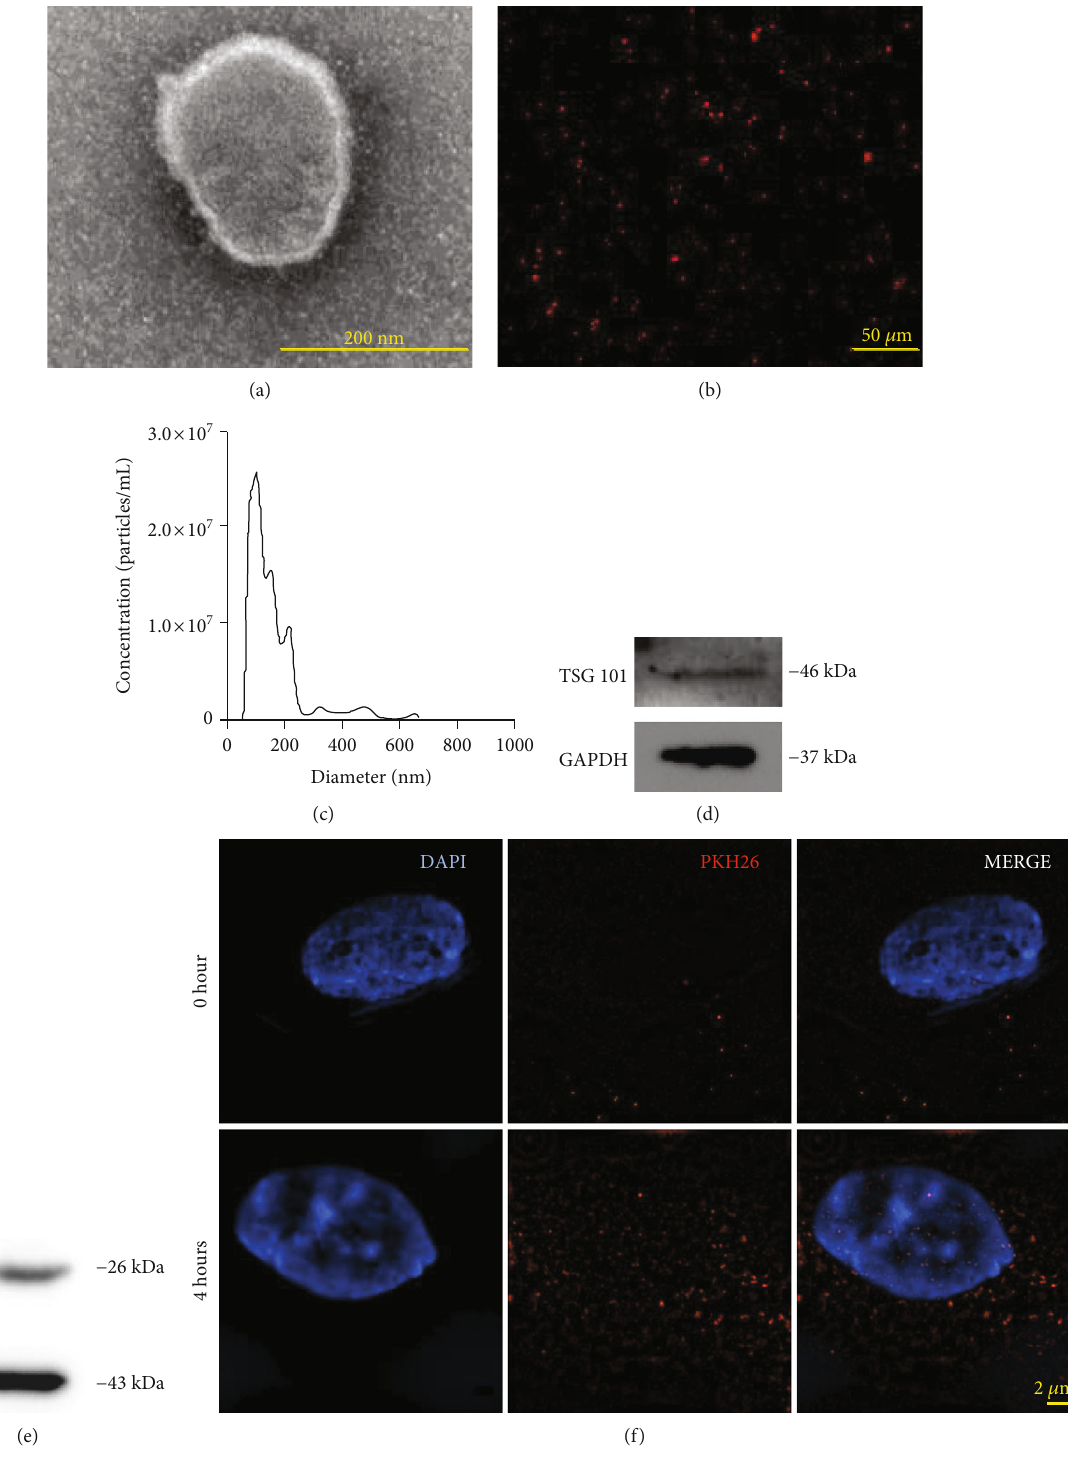
Figure 2: Identi fi cation and internalization of ADSC-EVs. (a) Transmission electron microscopy image of ADSC-EV after negative staining shows EVs are on average about 200 nm. Scar bar = 200 nm . (b) Picture of ADSC-EVs labeled with the red fl uorescent dye PKH26. Scar bar = 50 μ m . (c) Nanosight pro fi le of ADSC-EVs. Their sizes and concentrations are shown. Diameter distribution peaks at around 166nm. (d) Western blot results showing positive expression of TSG101 (EV surface markers) and (e) VEGF in ADSC-EVs. (f) PKH26- labelled ADSC-EVs (red fl uorescence) were added to HUVECs (nuclei were stained by DAPI); representative structured illumination microscopy images are shown. Scar bar = 2 μ m